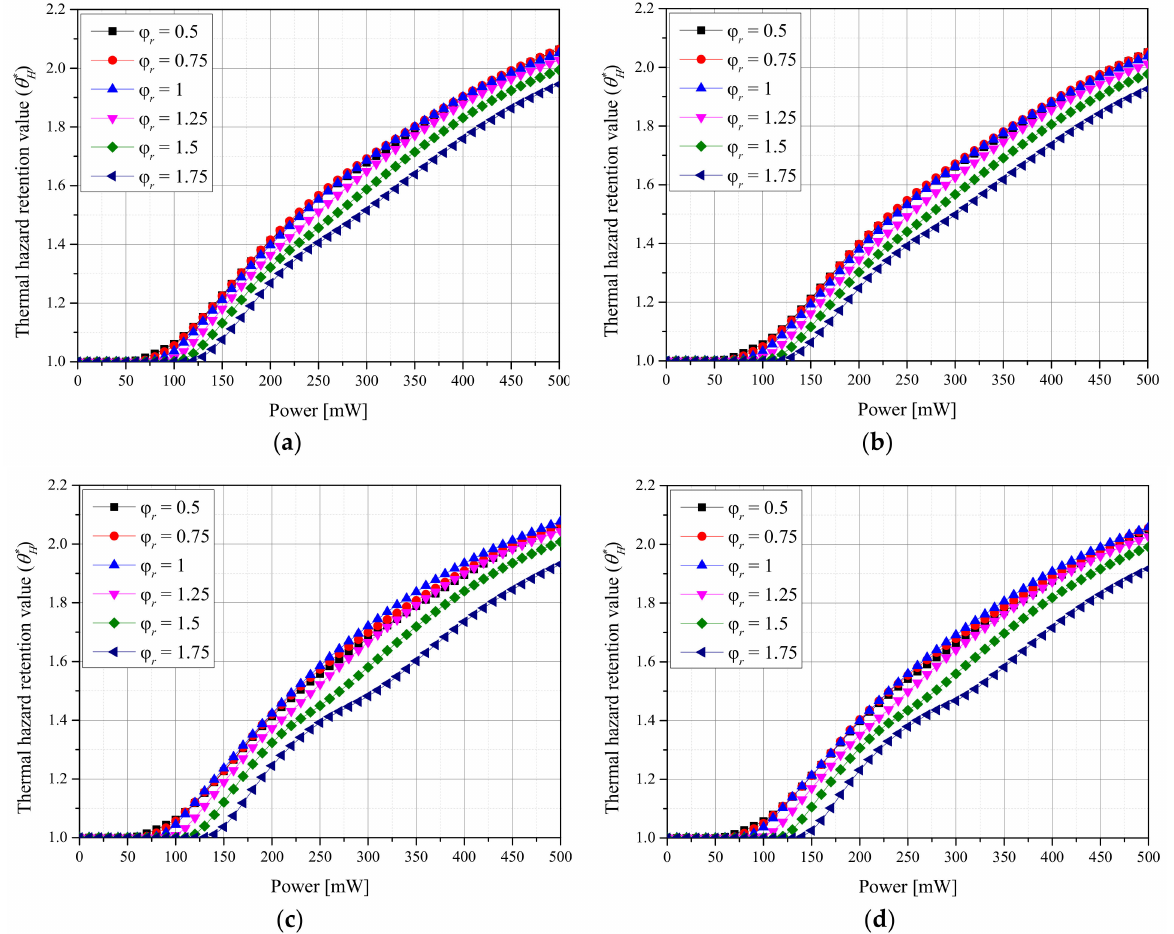
Figure 4. ( a ) Gaussian profile, f v = 10 − 3 . ( b ) Gaussian profile, f v = 10 − 6 . ( c ) Top-hat profile, f v = 10 − 3 . ( d ) Top-hat profile, f v = 10 − 6 . Thermal hazard retention value ( θ ∗